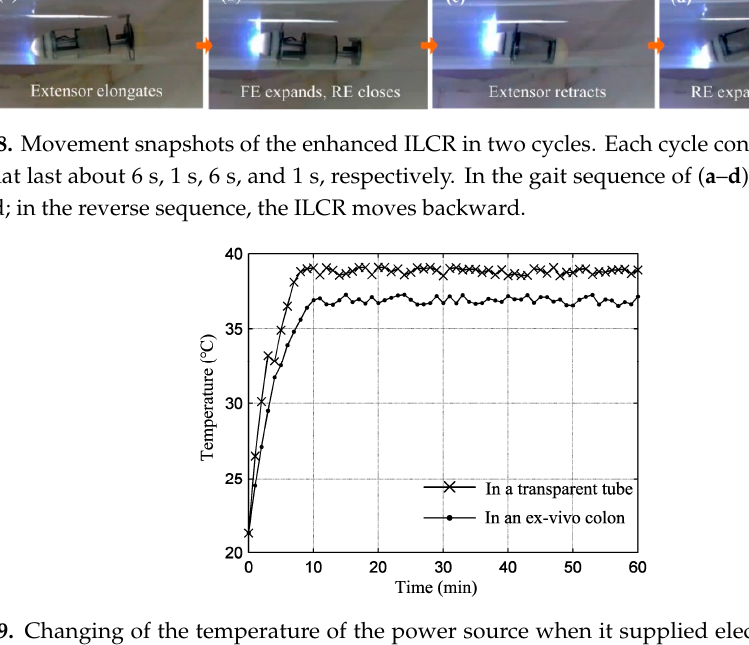
Figure 9. Changing of the temperature of the power source when it supplied electric power to the enhanced ILCR